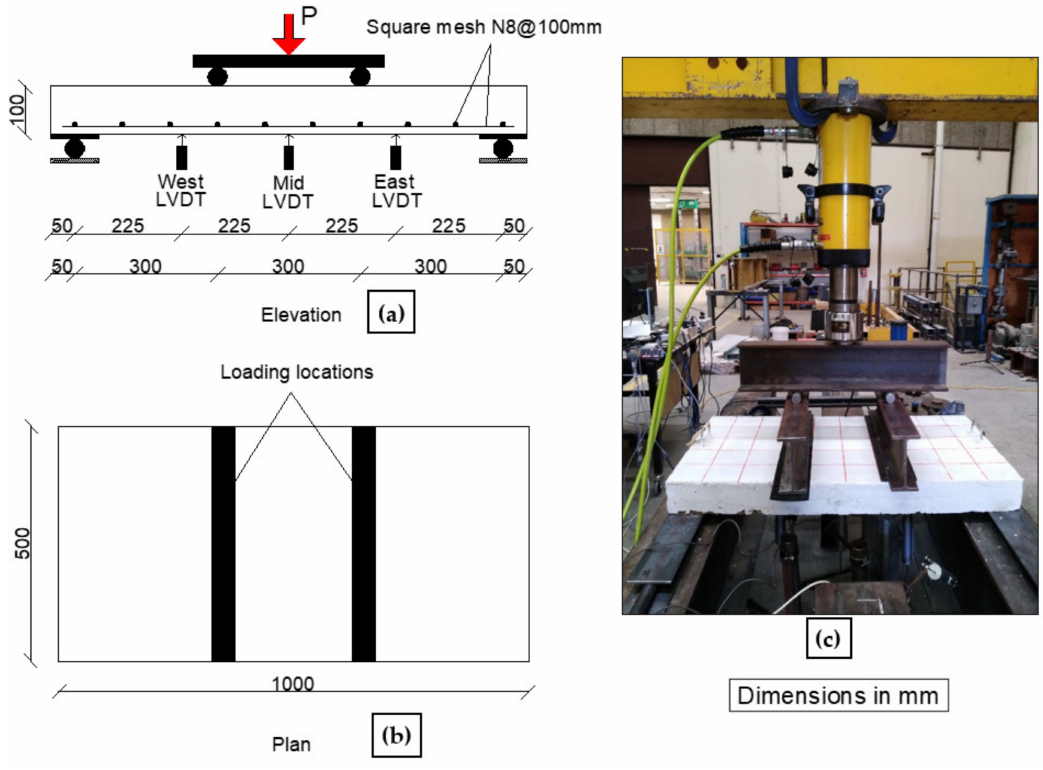
Figure 5. Slab geometry ( a , b ), reinforcement details ( a ), and test setup ( c